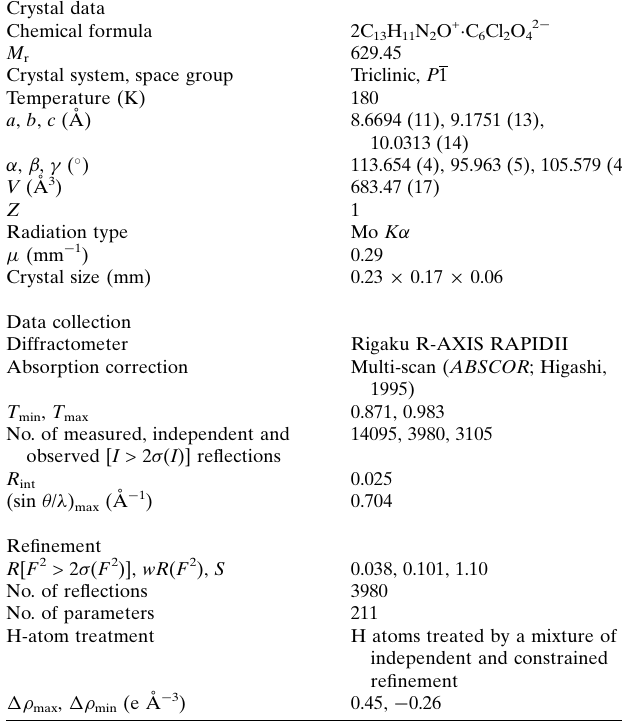
Table 1 Hydrogen-bond geometry (A˚ , (cid:4) ).